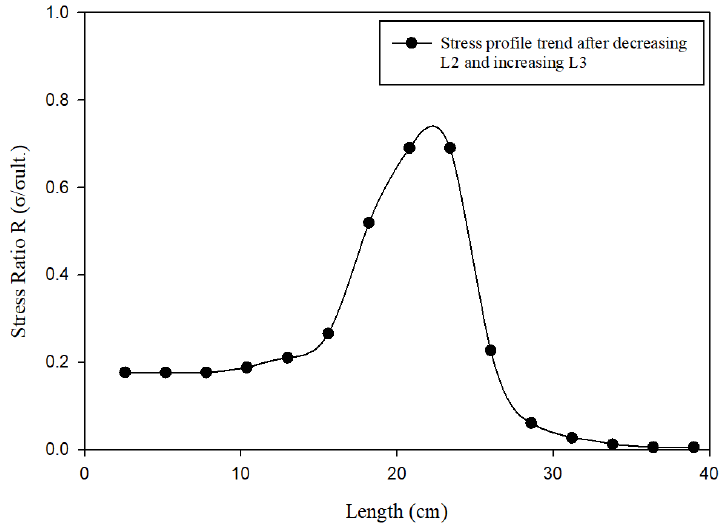
Figure 9. Stress profile after modifying L3 and L2.